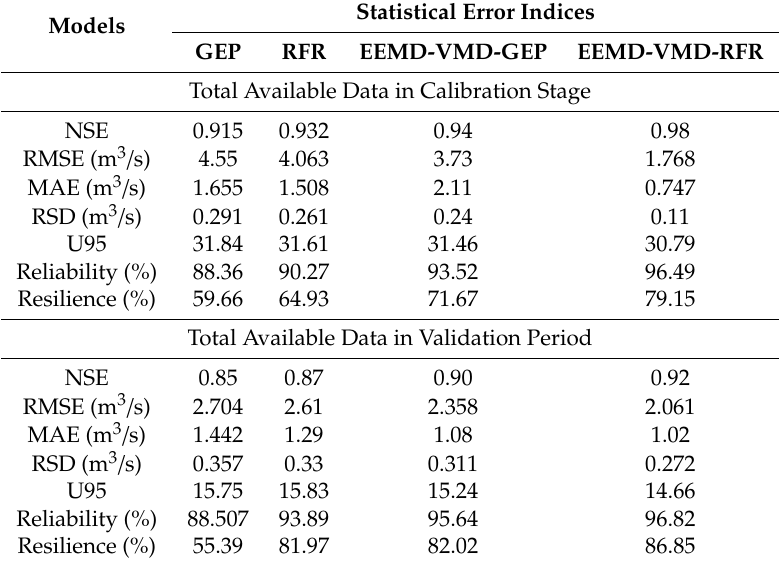
Table 7. Evaluation metrics of the proposed models in the calibration and validation periods at the Bilghan station.